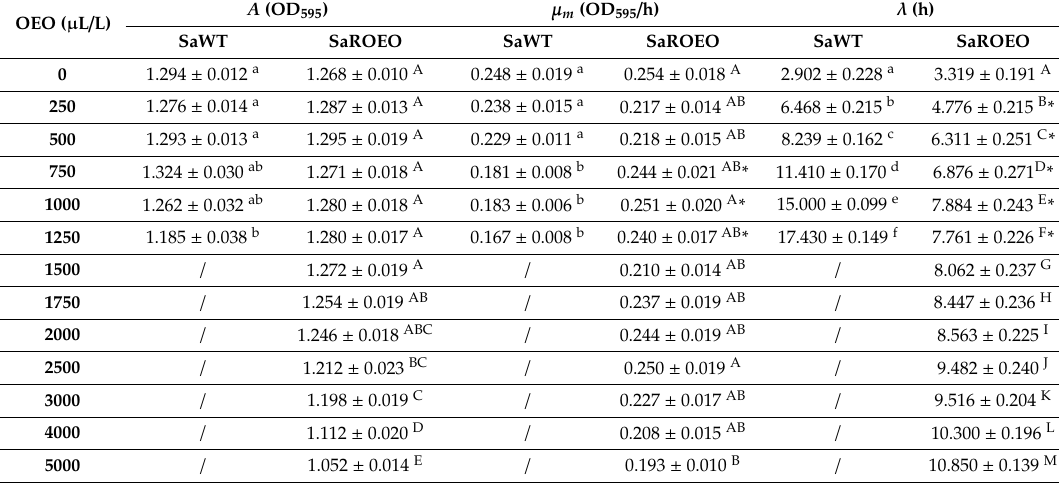
Table 2. A (maximum OD 595 ), µ m (maximum specific growth rate) and λ (lag phase time) parameters of the modified Gompertz model obtained from growth curves of Staphylococcus aureus USA300 (SaWT) and evolved strain (SaROEO), at di ff erent concentrations of orange essential oil (OEO). Each value represents the mean ± standard deviation from 3 independent